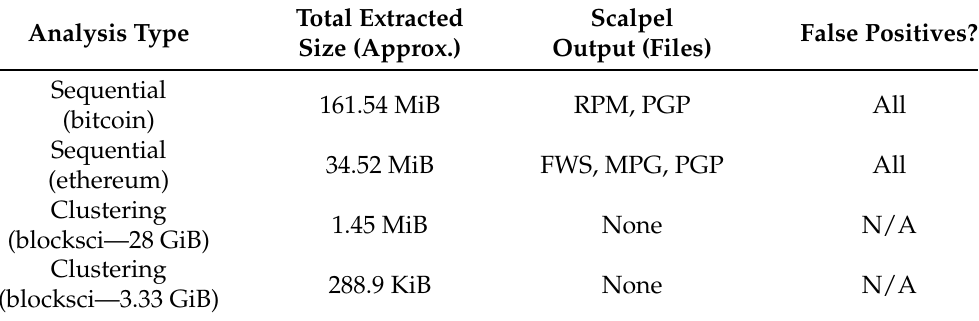
Table 6. Summary of the file carving results by analysis type, considering the extracted LSB of